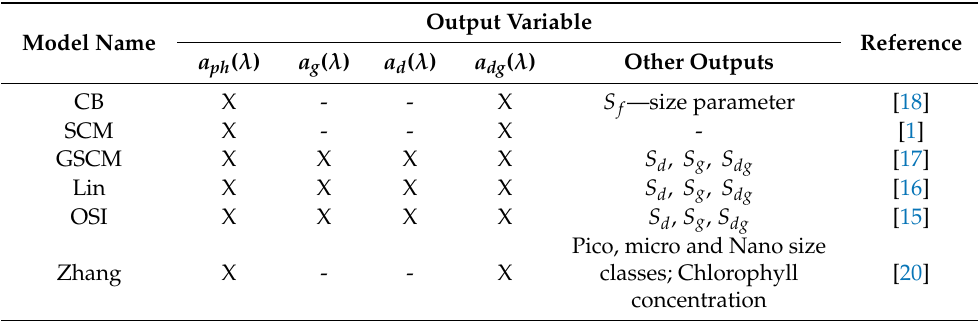
Table 1. Absorption spectrum decomposition algorithms used in the study with outputs. “X” indicates the outputs provided by each